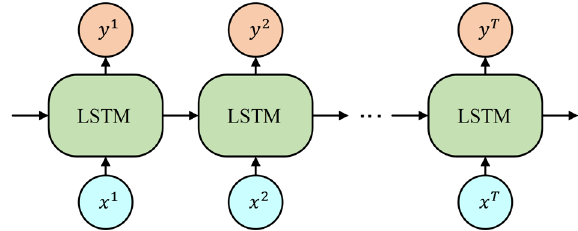
Figure 4. Example of connection between single-layer LSTM network.